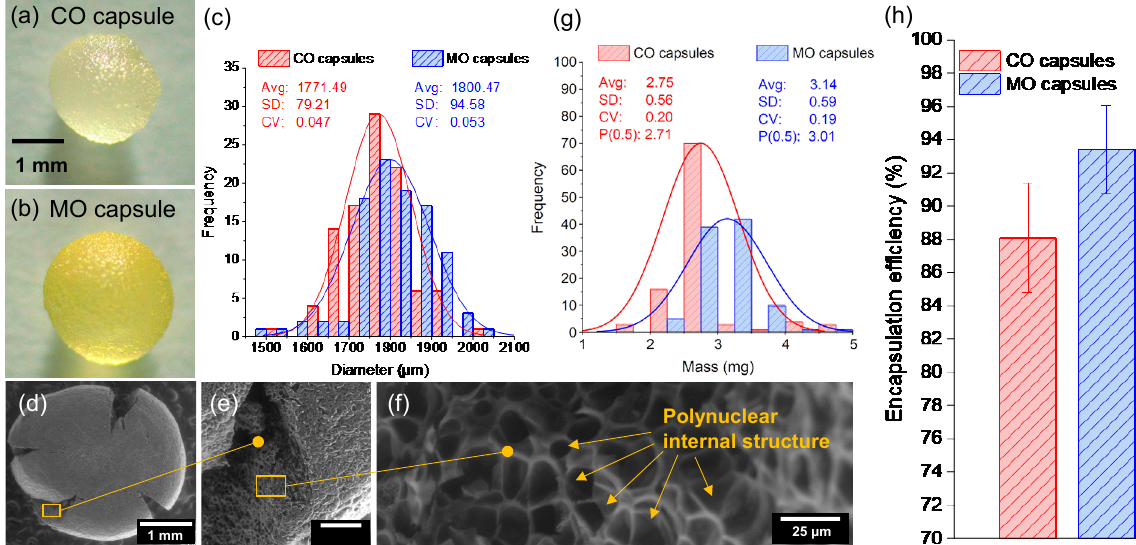
Figure 5. (a-b) Optical images of CO and MO biocapsules, respectively; (c) Frequency histograms of the diameter of the CO and MO biocapsules fitted to a normal distribution; (d-f) SEM images showing the polynuclear internal microstructure of the biocapsules; (g) Frequency histograms of the mass of the CO and MO biocapsules fitted to a normal distribution; and (h) Average results of the encapsulation efficiency of CO and MO